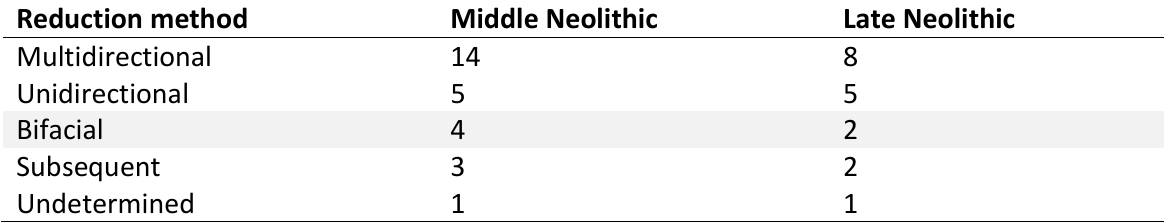
Table 6. Reduction methods observed within the assemblage, divided by